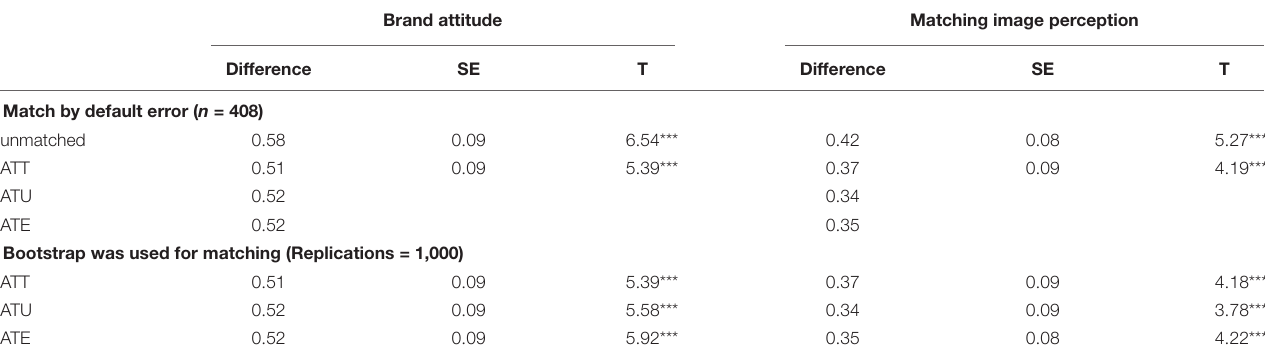
TABLE 3 | Analysis on the effect value of news feed advertising.